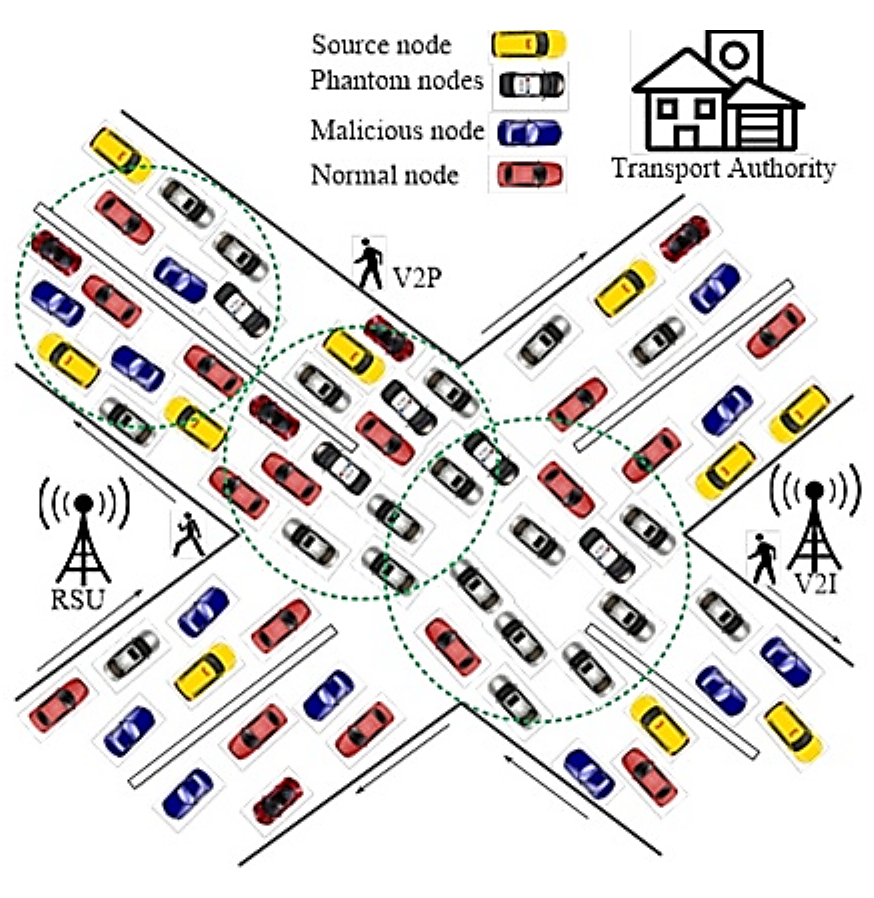
Figure 5. System Model.